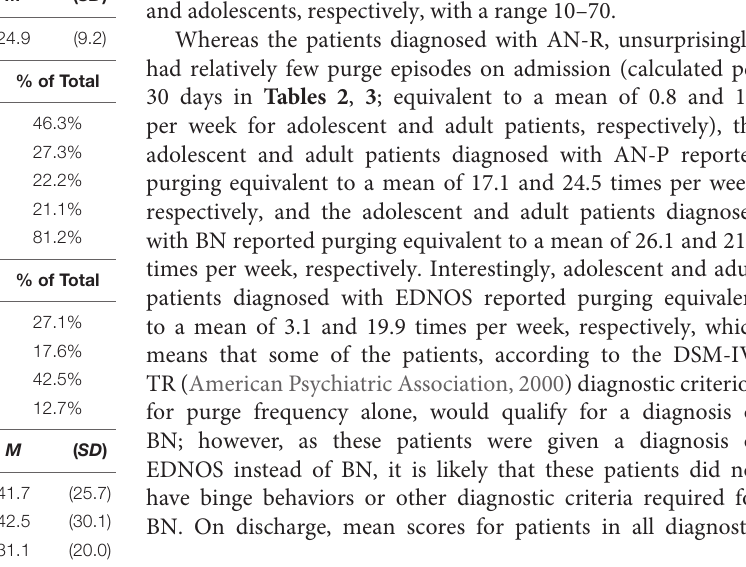
and adolescents, respectively, with a range 10–70.